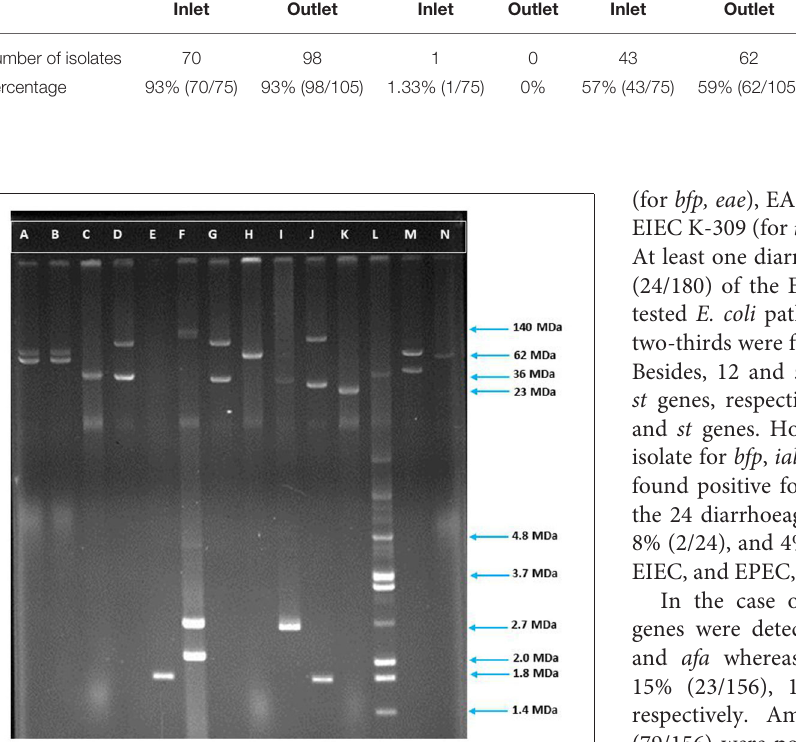
antibiotic resistance genes are mostly plasmid coded (7, 8). We, therefore, determined the plasmid number and size in ESBL positive E. coli isolates. Plasmid analysis showed that 84% (151/180) of the isolates contained plasmids of different sizes ranging from 1.19 to